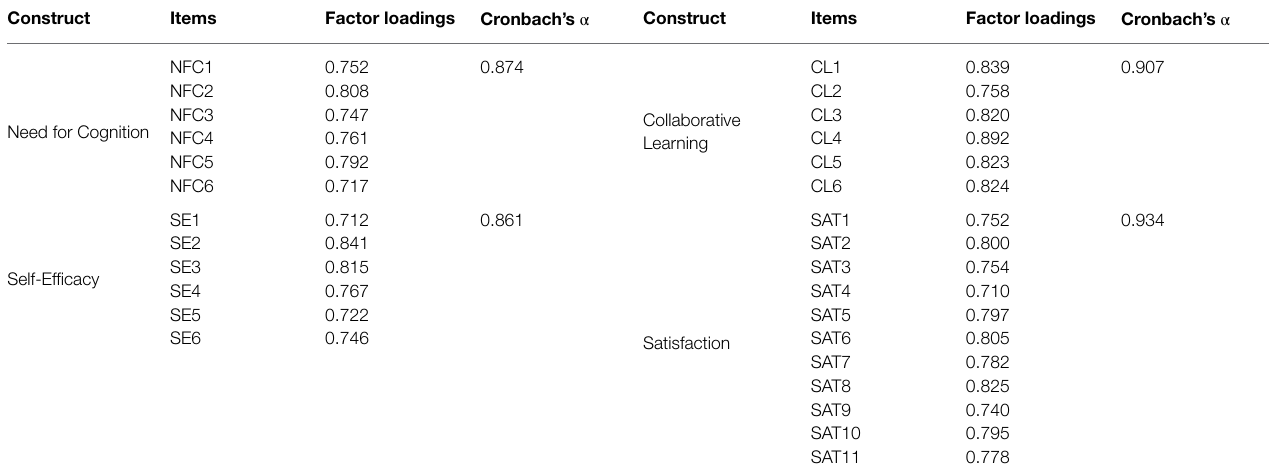
TABLE 3 | Validity and reliability test